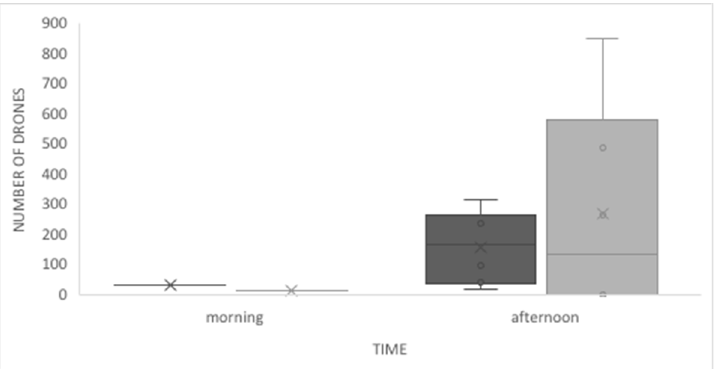
Figure 3. Drones’ flight activity as determined by video recording (dark grey) and direct observations (grey), in the morning and afternoon in Tucumán, NW Argentina.